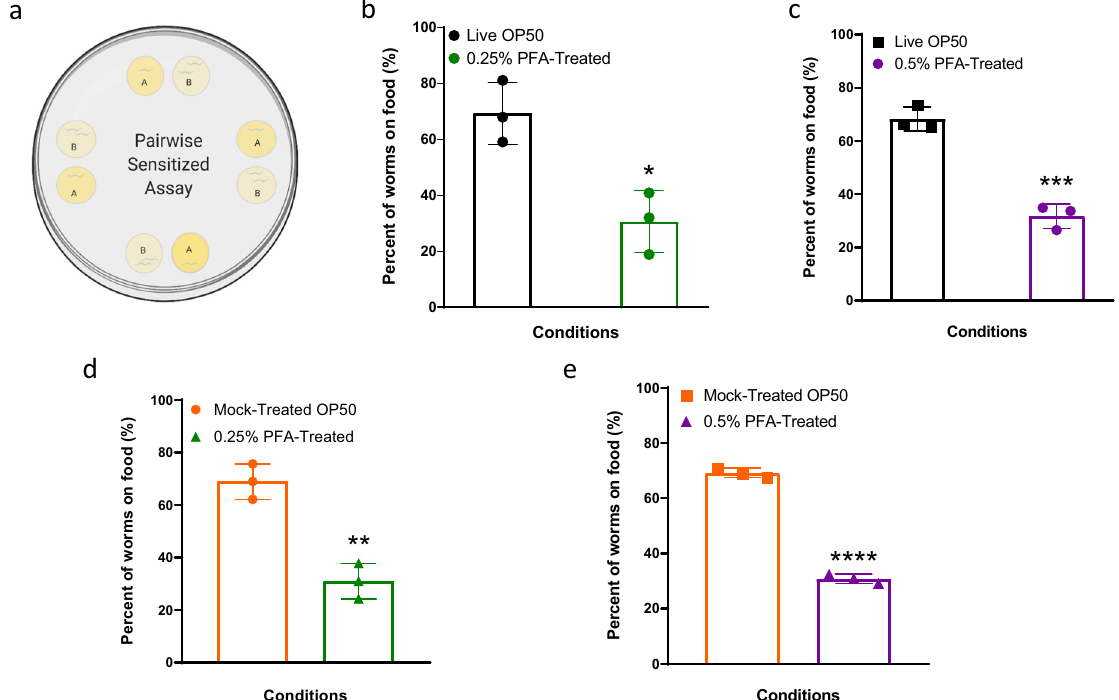
Fig. 4 Worms prefer live and mock-treated bacteria over PFA-treated bacteria. a A schematic of the pairwise sensitized assay plate testing preference between two bacteria conditions at a time. Percent of worms on b ) Live OP50 vs. 0.25% PFA-treated, c Live OP50 vs. 0.5% PFA-treated, d Mock-treated OP50 vs. 0.25% PFA-treated, and e Mock-treated OP50 vs. 0.5% PFA-treated. Single asterisk denotes p -value < 0.05, double asterisks denote p -value < 0.002, triple asterisks denote p -value < 0.001, and quadruple asterisks denote p -value < optical density 24 . We found that L4 worms grown on the PFA- treated OP50 bacteria showed reduced TOF, suggesting that their population is smaller in size (Fig. 5b and Supplementary Fig. 7).